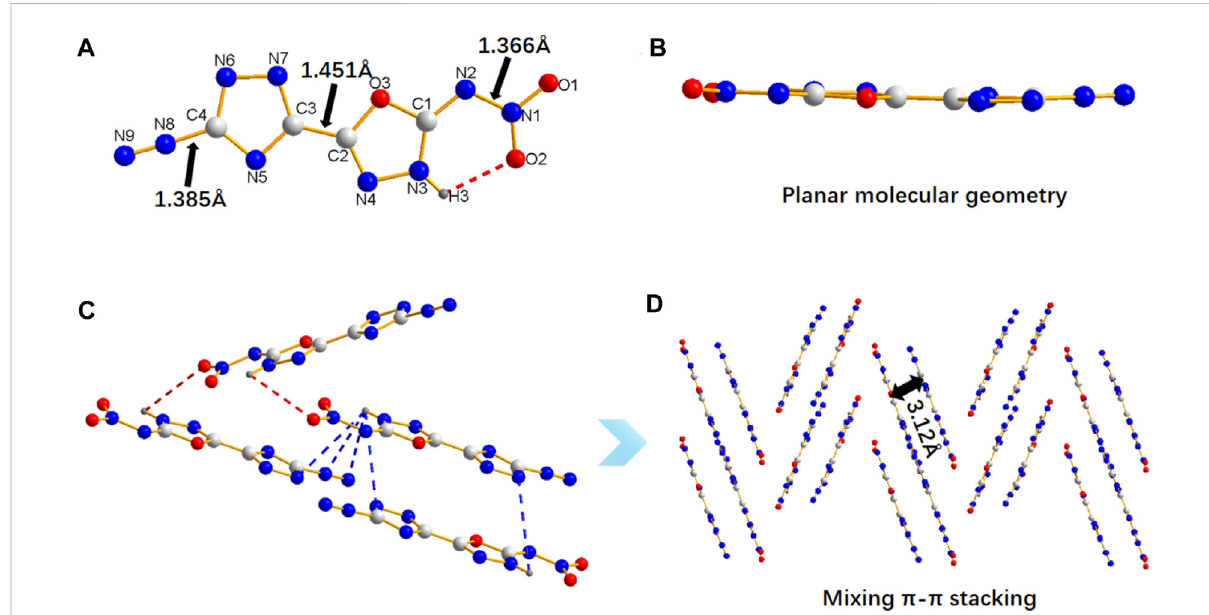
FIGURE 2 The molecule and crystal stacking structure of 5. (A) The crystal structure of 5. (B) The planar molecular geometry of 5. (C) The intermolecular hydrogen bonds of 5. (D) The crystal stacking structure of 5.